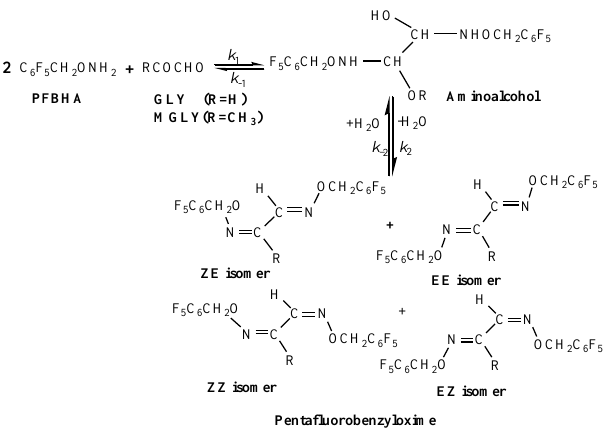
Fig. 2. Two-step process of derivatisation of GLY or MGLY with PFBHA to form the corresponding derivative oxime isomers. Three isomers are formed for GLY (ZE, EE, ZZ) and four isomers (ZE, ZZ, EZ, EE isomers) are potentially formed for MGLY.